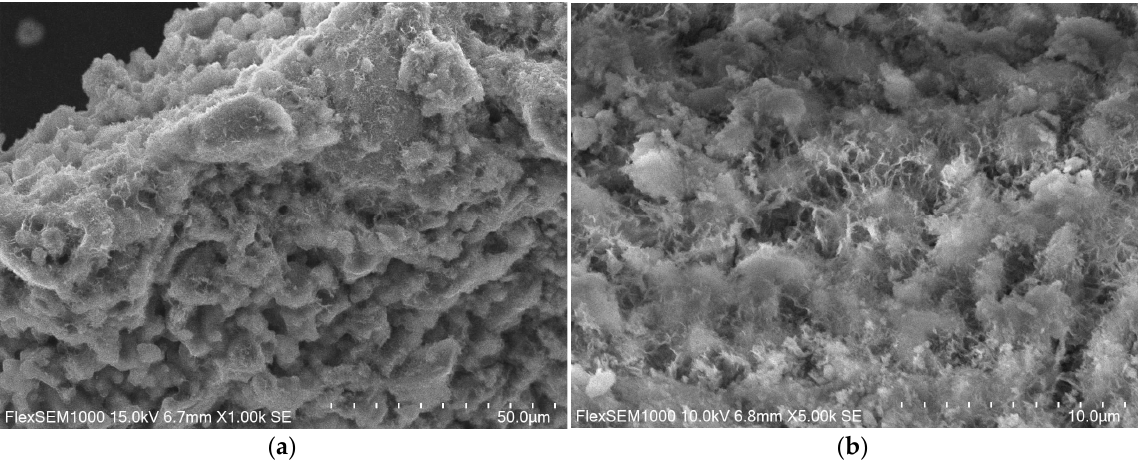
Figure 11. ZK1z10nc microstructure prepared in magnification of: ( a ) 1000×; ( b ) 500×.